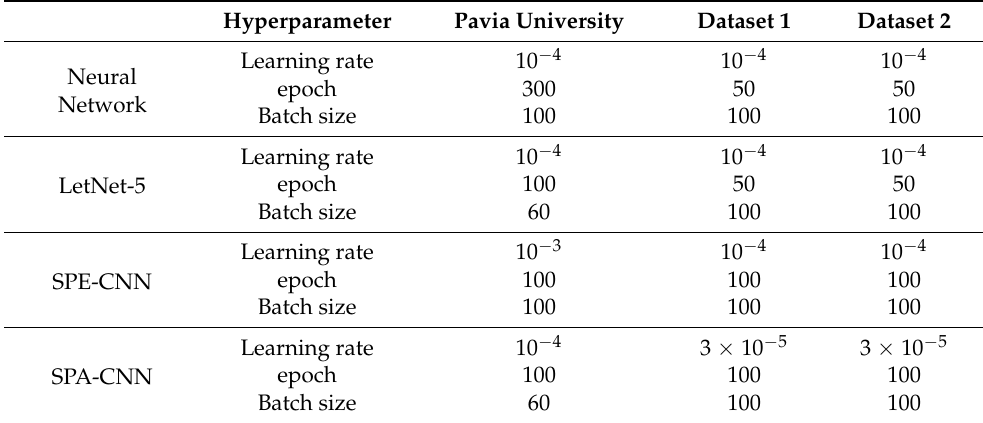
Table 5. The learning rate, epoch, and batch size of neural network, LetNet-5, SPE-CNN, and